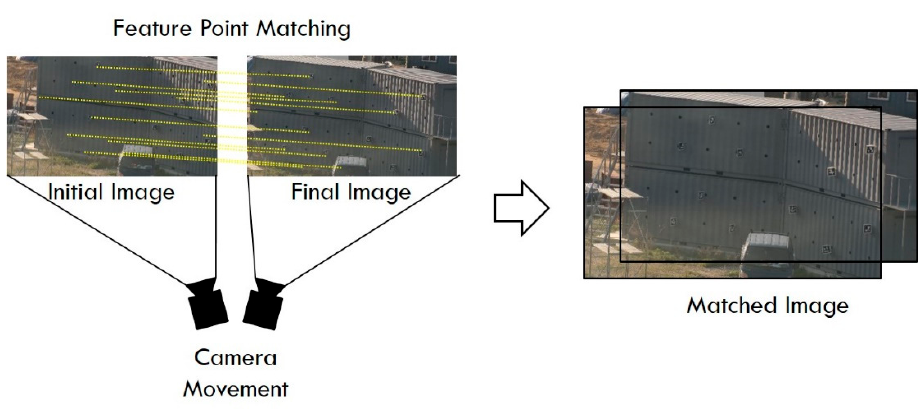
Figure 5. Image matching to correct camera movement error.